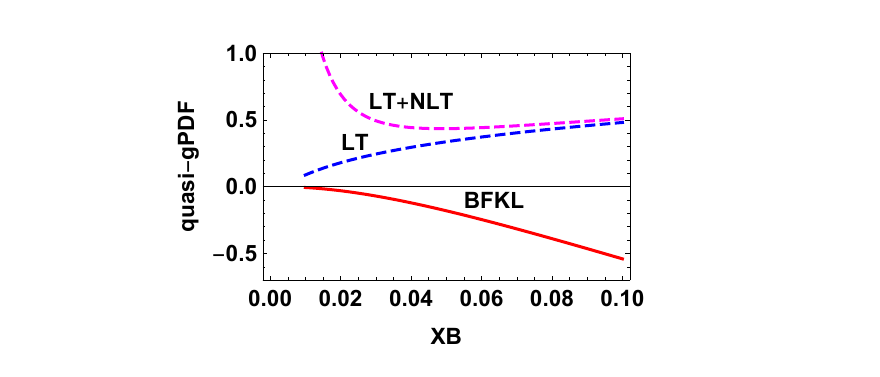
Figure 4. Here we plot the quasi-PDF with BFKL rsummation (real part), the LT and the LT + NLT (real part). [0 . 01 , 0 . 1] with P ξ = 4 GeV. The curves are plotted in the range x B ∈